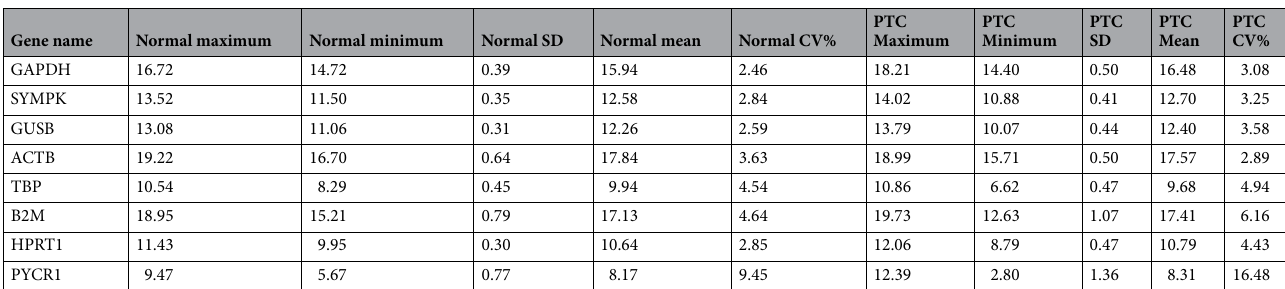
Table 5. TCGA dataset statistics for eight selected reference genes. TCGA database statistics are presented. HPRT1 (0.30), GUSB (0.31) and SYMPK (0.35) genes had the lowest SD values in normal tissues, respectively. The genes with the lowest SD values in PTC tissues are SYMPK (0.41), GUSB (0.44), TBP and HPRT1 (both 0.47). SD standard deviation, CV correlation of